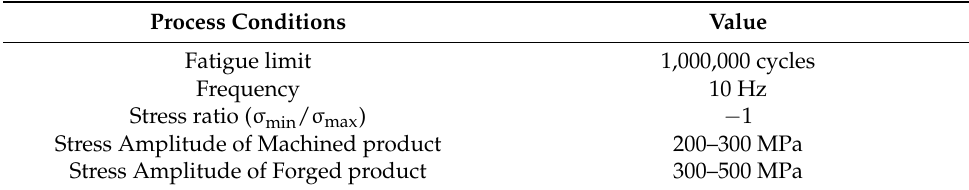
Table 2. Experimental conditions for the fatigue test.